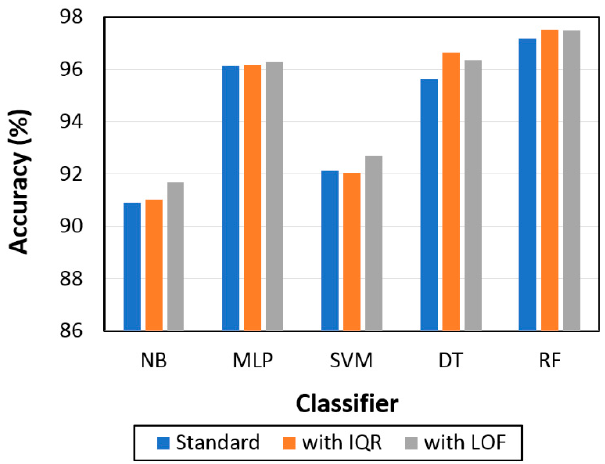
Figure 7. Outlier detection impact on classification model accuracy.